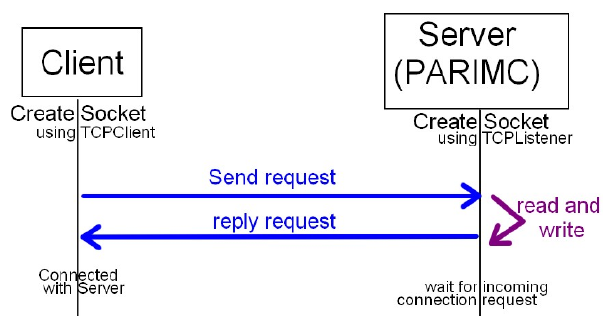
Figure 9. Communication between the mobile interface and